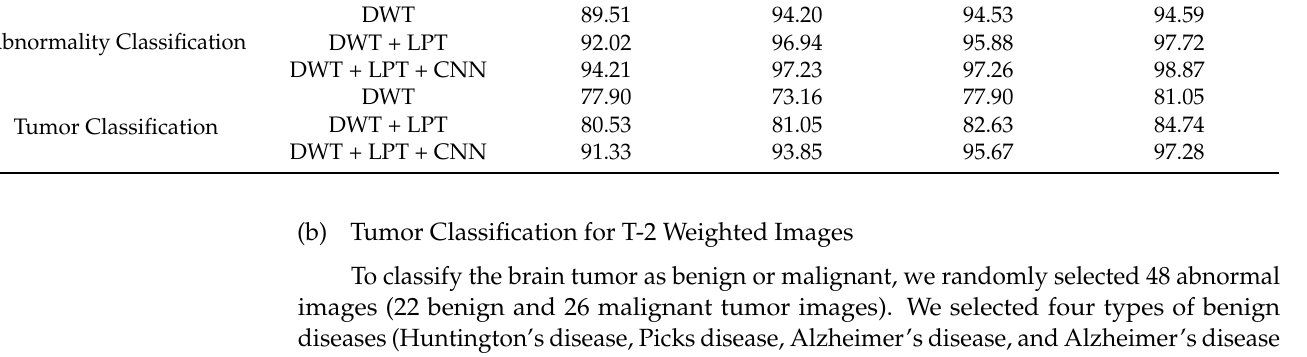
Figure 13. The accuracy percentages for the T-1 weighted images: ( a ) RBF; ( b ) Linear; ( c ) Polynomial; ( d ) Quadratic. Table 6. Average accuracy for T-2 weighted